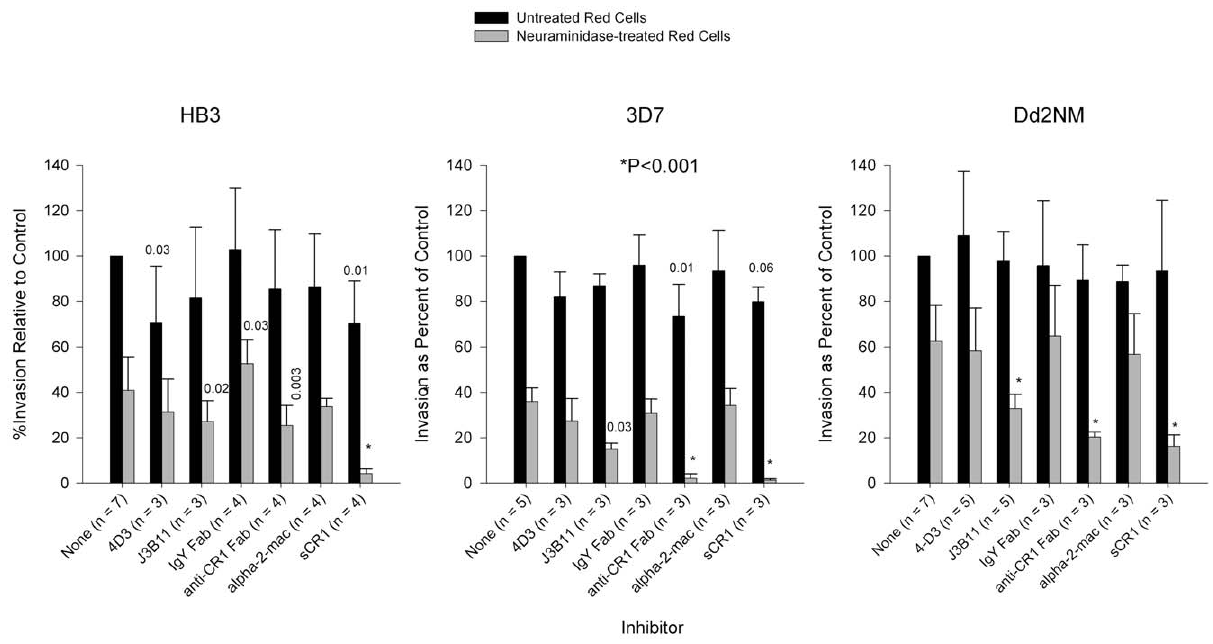
Figure 4. Inhibition of invasion of P.falciparum strains HB3, 3D7, and Dd2NM. HB3 invasion of neuraminidase-treated cells was least affected by monoclonal and polyclonal antibodies against CR1. Monoclonal antibodies were used at 4 m g/ml. Fab fragments were used at 8 m g/ml and purified proteins were used at 50 m g/ml. Numbers above bars are P values for the comparison with the no-inhibitor control using Dunnett’s pairwise multiple comparison t test, taking into account matching by experiment date. Bars represent means 6 standard deviations. Alpha-2-mac= a -2-macroglobulin. Invasion rates for untreated erythrocytes with no inhibitor ranged from 3% to 37%.